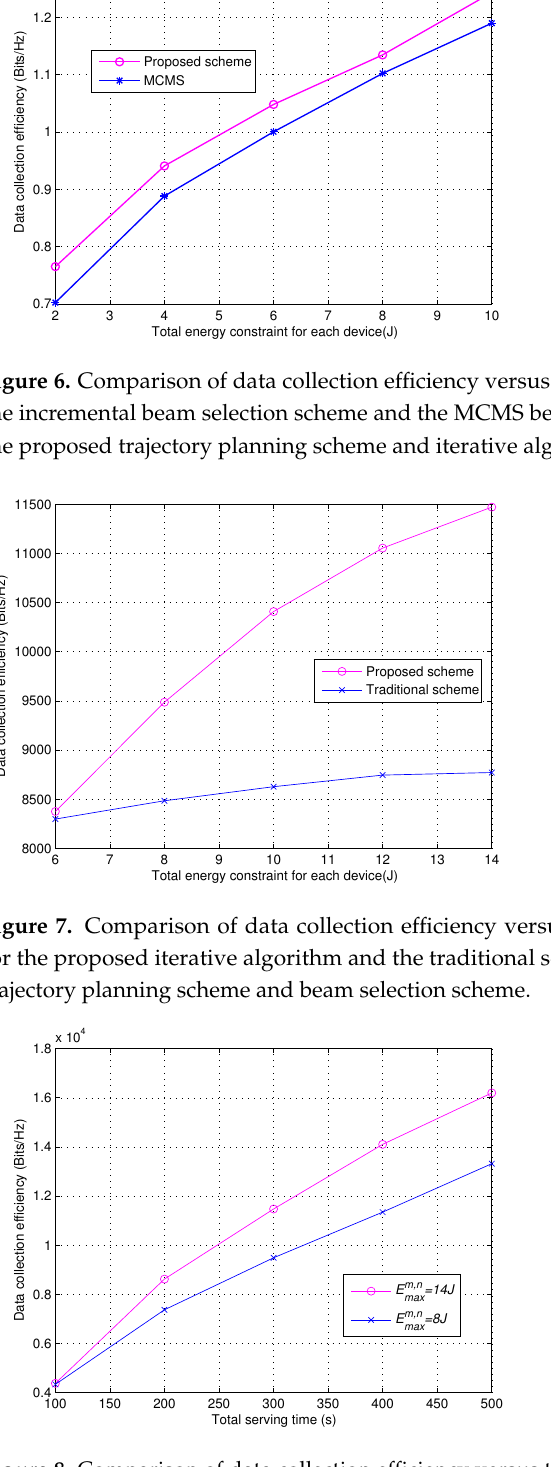
Figure 8. Comparison of data collection efficiency versus the total serving time for proposed scheme with E m , n max = 8/14